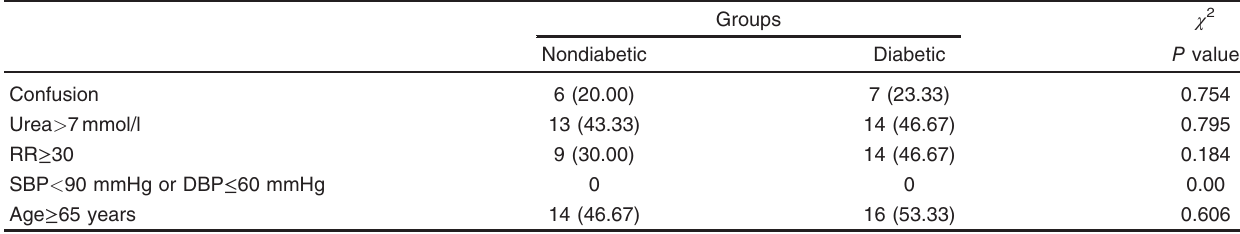
Table 3 CURB-65 score in nondiabetic and diabetic patients